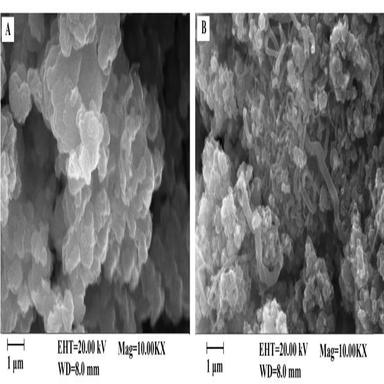
SEM images of (A) N-C and (B) Ni NPs/N-C nanohybrid.